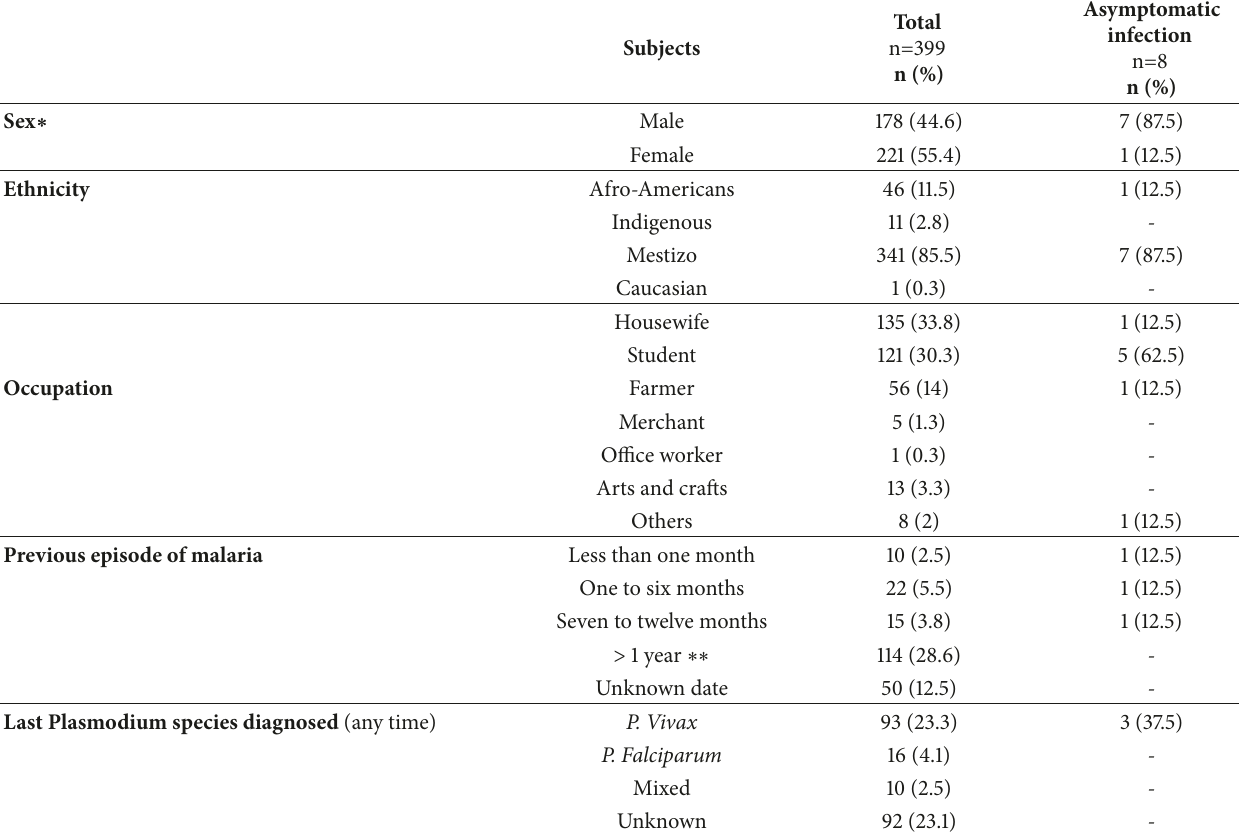
Table 1: Sociodemographic